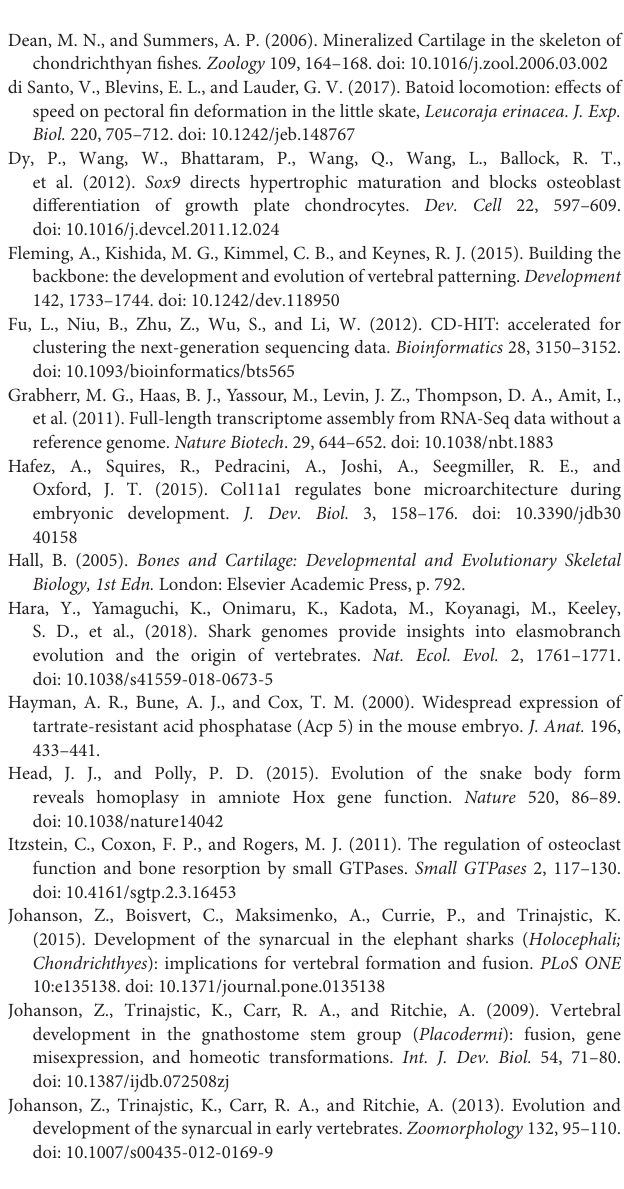
Table S1 | Annotation of the Ler_Trinity_CRBB transcriptome. Annotations were extracted from the DAVID knowledgebase v 6.8 and transferred to the Leucoraja erinacea transcripts based on the unique Refseq ID. Table S2 | Cartilage genes. The subset of transcripts annotated to the gene ontology term “cartilage development” (GO:0051216). Table S3 | Bone resorption genes. The subset of transcripts annotated to the gene ontology term “bone resorption” (GO:0045453). Table S4 | Osteoclast genes. The subset of transcripts annotated to the gene ontology term “osteoclast” (GO:0045453). Table S5 | Hox genes. The subset of transcripts annotated with the SMART hox domain